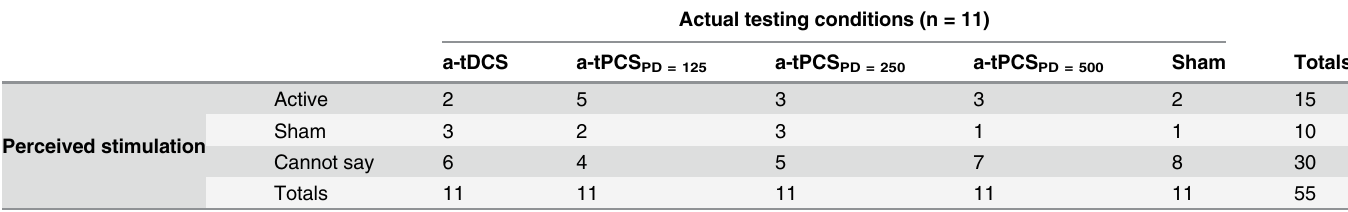
Table 3. Number of subject ’ s who guessed the active or sham stimulation